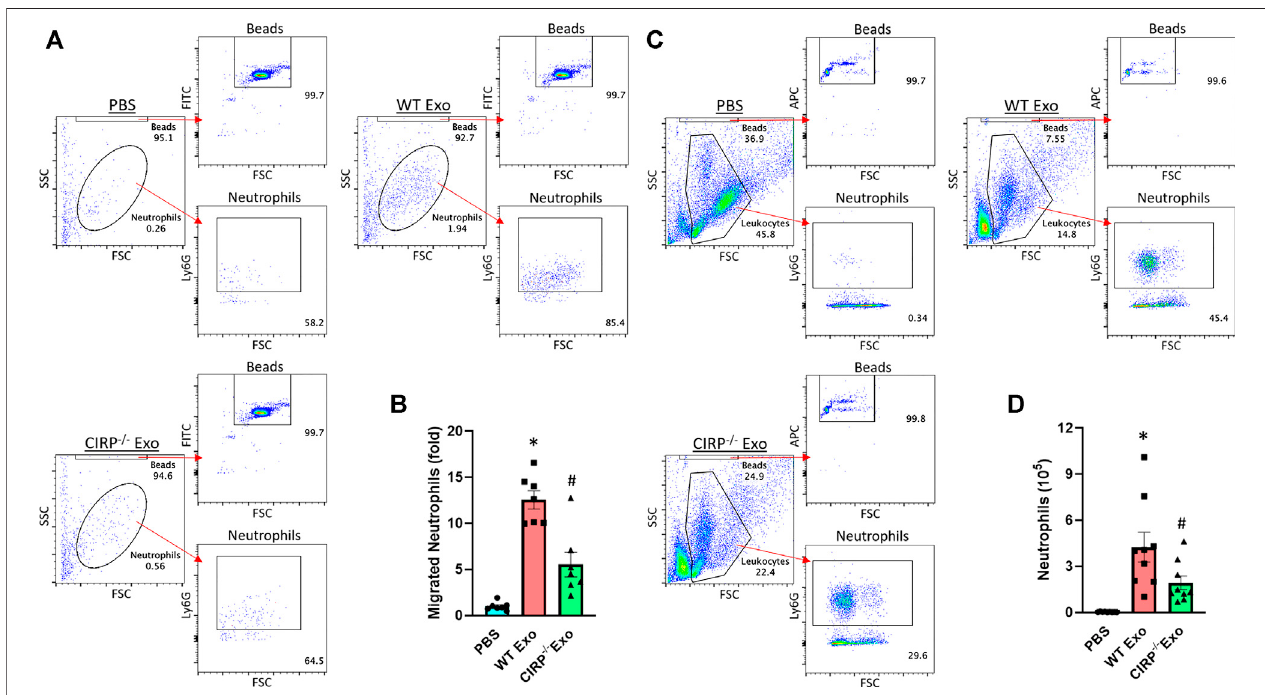
FIGURE 6 | Exosomal eCIRP promotes neutrophil migration. Migration of neutrophils (5 × 10 5 ) was assessed using 5 μ g/ml of exosomes isolated from WT or CIRP − / − mice challenged with LPS as attractants. After 4 h the number of migrated neutrophils was counted by fl ow cytometry and was normalized to PBS group. (A) Representativedotpotsand (B) bardiagramareshown.Dataareexpressedasmeans ± SE( n (cid:2) 7samples/group).Thegroupswerecomparedbytwo-wayANOVAand SNK method (* p < 0.05 vs PBS; # p < 0.05 vsWT exosomes).WT mice were intraperitoneally injected with exosomes isolatedfrom WT or CIRP − / − mice challenged with LPS. After 4 h the number of in fi ltrated neutrophils in the peritoneal lavage was assessed by fl ow cytometry. (C) Representative dot pots and (D) bar diagram are shown.Dataareexpressedasmeans ± SE( n (cid:2) 9samples/group).Thegroupswerecomparedbytwo-wayANOVAandSNKmethod(* p < 0.05vsPBS; # p < 0.05vsWT